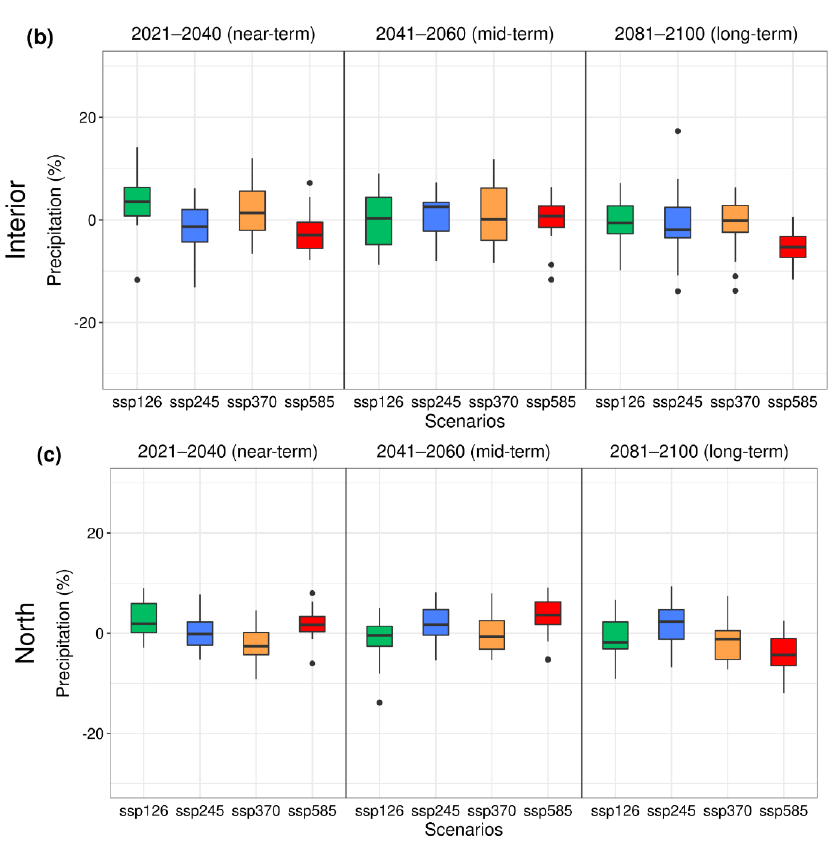
Figure 9. Boxplot of the relative change in precipitation for the near-term, mid-term, and long-term (end of the century) periods: ( a ) East Coast, ( b ) Interior, and ( c ) North. The colored box plot corresponds to the average of the 15 models (ensemble) of CMIP6 for the SSP1-2.6, SSP2-4.5, SSP3-7.0, and SSP5-8.5 scenarios.